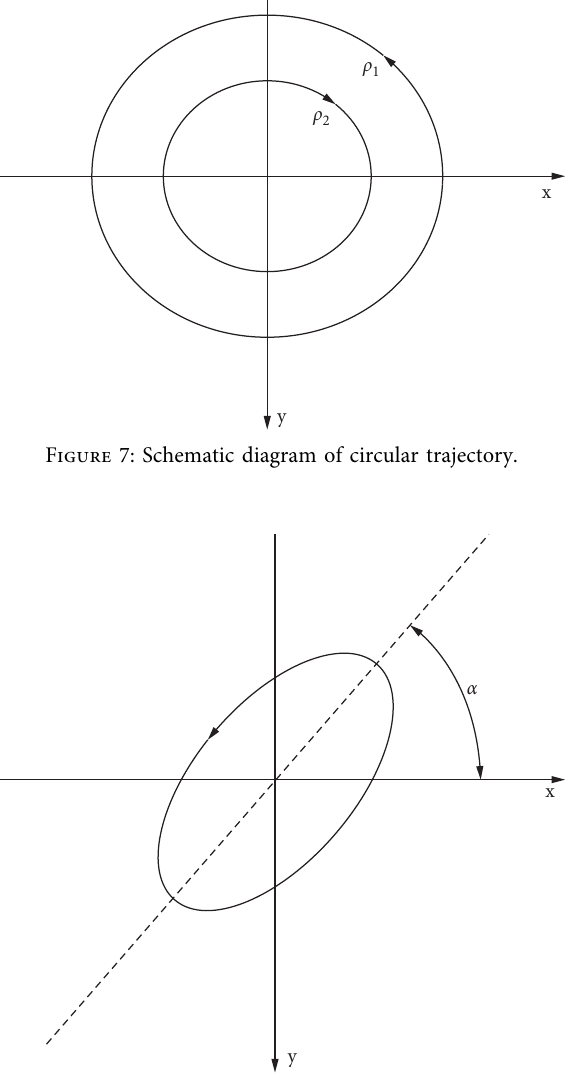
Figure 8: Schematic diagram of ellipse motion